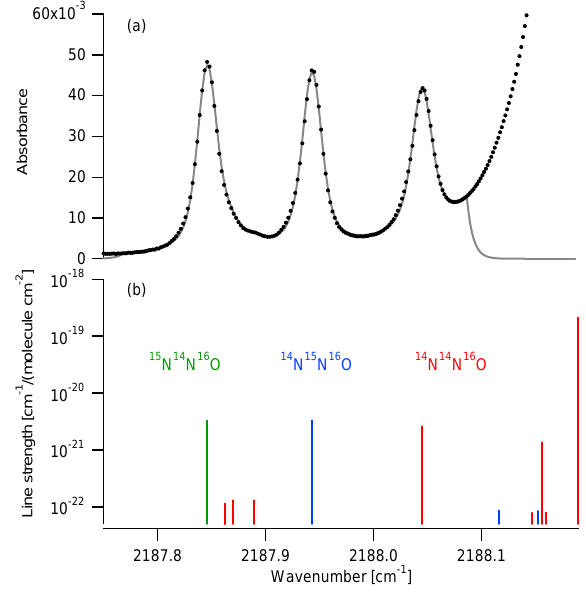
Fig. 3. (a) Measured (dots) and fitted spectrum (solid line) of the N 2 O isotopic species at 90ppm and (b) the corresponding line strengths. The tail of a strong absorption line of 14 N 14 N 16 O (2188.19cm − 1 ) is clearly visible and was considered in the fit up to 2188.1cm − 1